Question: Identify the chart type used in this figure.
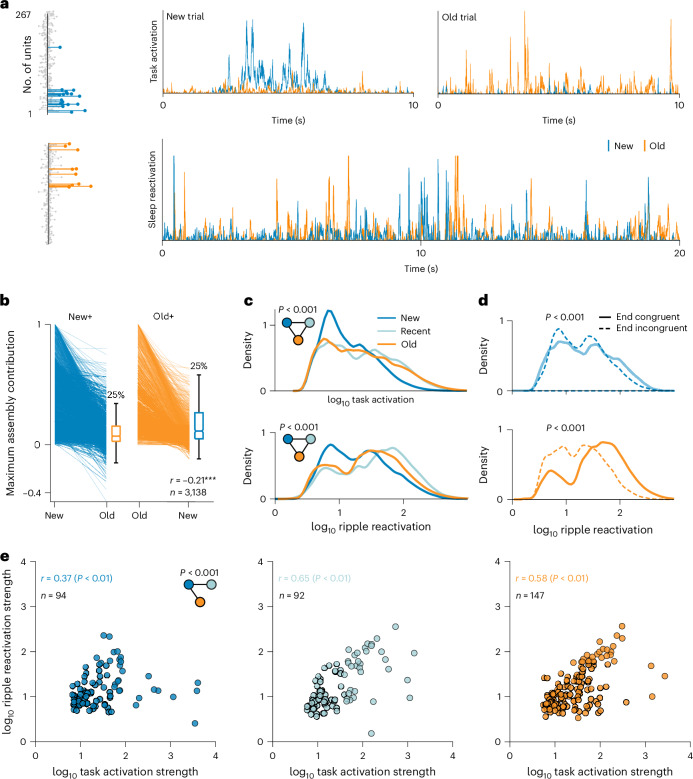
Answer: scatter